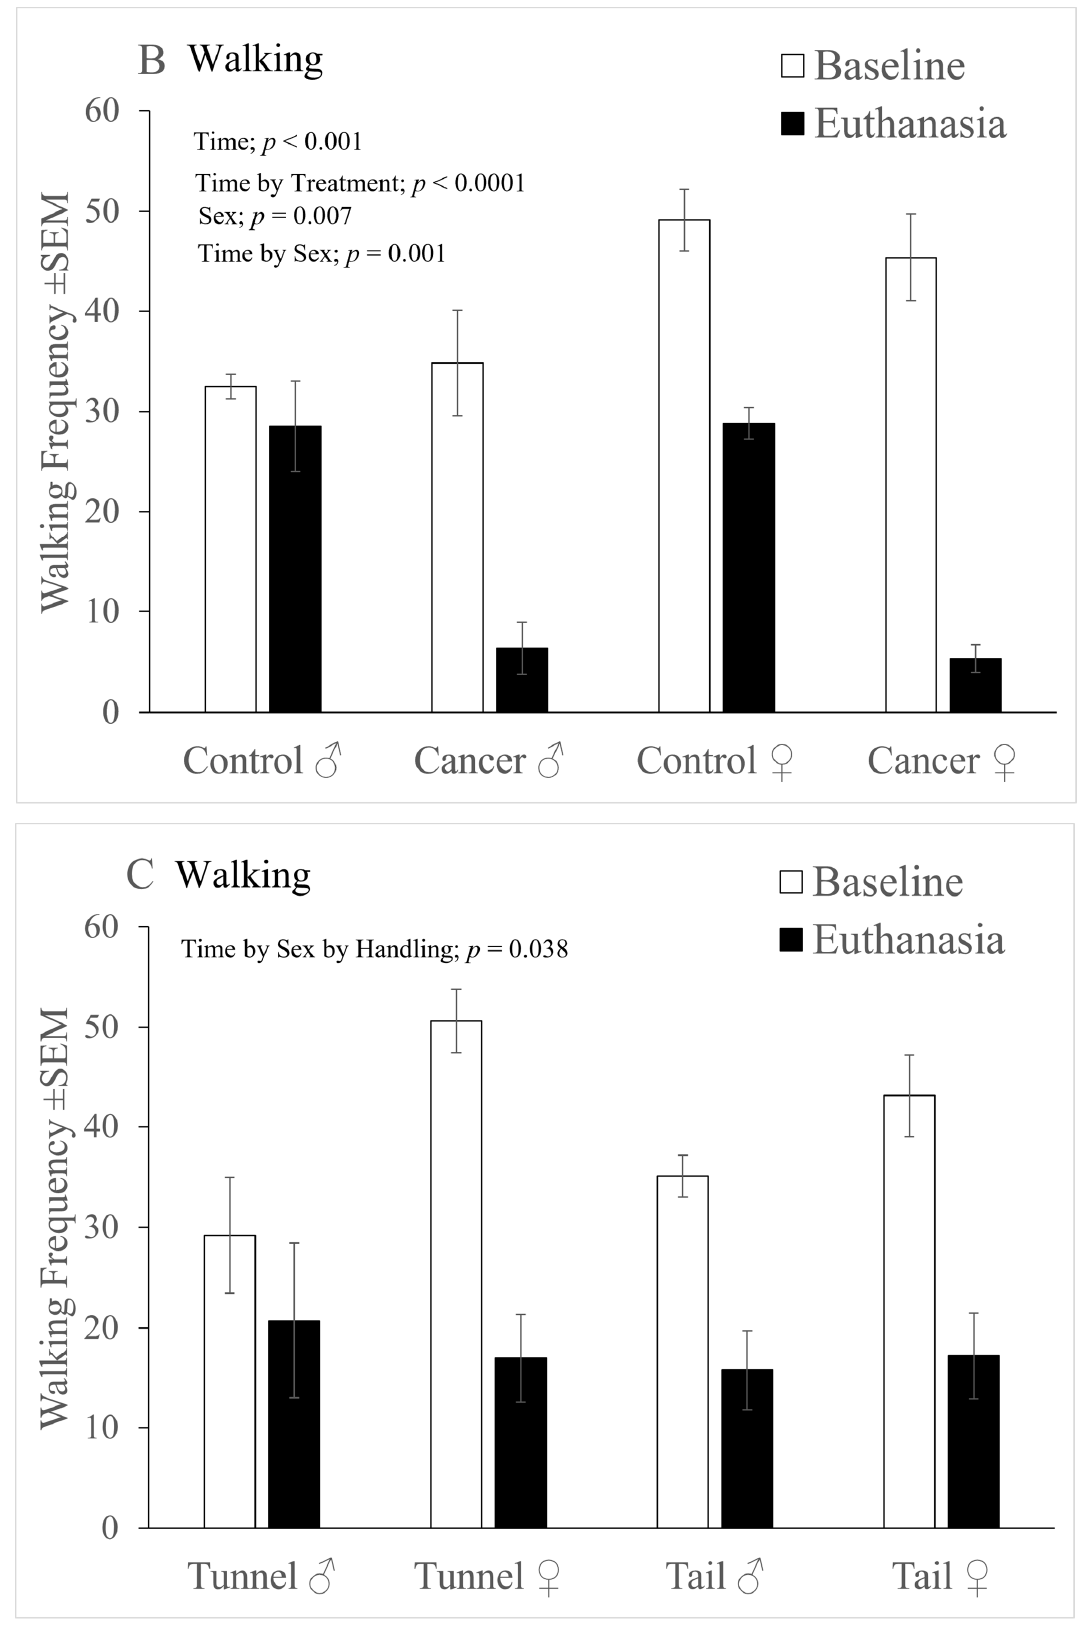
Figure 3. The mean frequencies of rearing ( A ) and walking behaviour ( B , C ) (±SEM) from baseline to euthanasia, indicating significant effects of the factors ‘Time’, ‘Treatment’, ‘Sex’ and Handling’ (with p values). ( A ) Rearing significantly declined in all mice over Time (‘Time’ factor significant), but more so in those with cancer (significant ‘Time’ by ‘Treatment’ inter- action). ( B ) Regardless of the recording point females generally walked more than males (‘Sex’ factor significant), and all mice walked less as time progressed (‘Time’ factor significant). However, the decline in walking from baseline to eutha- nasia was relatively greater in females (significant ‘Time’ by ‘Sex’ interaction). Additionally, the overall reduction was greater in cancer bearing mice (significant ‘Time’ by ‘Treatment’ interaction). ( C ) Depicts that the greater decline in walk- ing in females from baseline to euthanasia was primarily due to a greater reduction in walking movements made by those females that were in the NAH group (significant ‘Time’ by ‘Sex’ by ‘Handling’ (3-way interaction)). ( A ): Cancer/Control n = 16. ( B ): Cancer, male/female n = 7/9, Control male/female n = 7/9. ( C ): Tunnel, male/female n = 6/10, Tail, male/female n = 8/8. ♂ : male; ♀ : female. HCS was set to assign motionless periods to ‘sleeping’ if there was a total lack of movement in 95% of the preceding 5 s. Instances of this were only in the cancer group on the final day before the euthanasia group (on 53 ± 23 occasions). Grooming had similar tolerance settings, i.e., when minor movements were detected, but without mice travelling any distance. This was also only detected in the cancer group. There were 2.6 ± 1.8 groom- ing episodes at baseline and 42 ± 8.8 on the euthanasia day, resulting in a significant ‘Time’ effect (F(1,12) = 14.6, p = 0.002). Sleeping and grooming were similar in males and females and the frequency of each was unaffected by handling method. 3.4. MGS and Von Frey MGS scores were similar between the cancer and control groups at baseline (0.87 ± 0.5 vs. 0.8 ± 0.45, cancer vs. control). They remained unchanged from baseline to euthana-